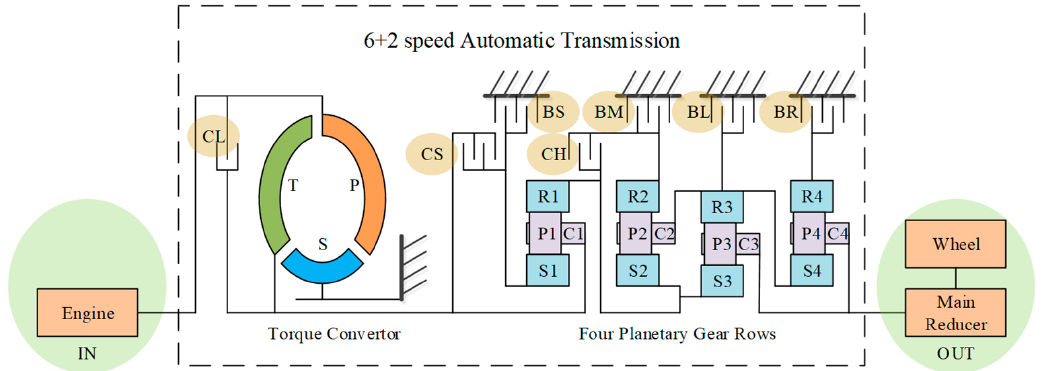
Figure 1. 6 + 2 speed AT powertrain system.